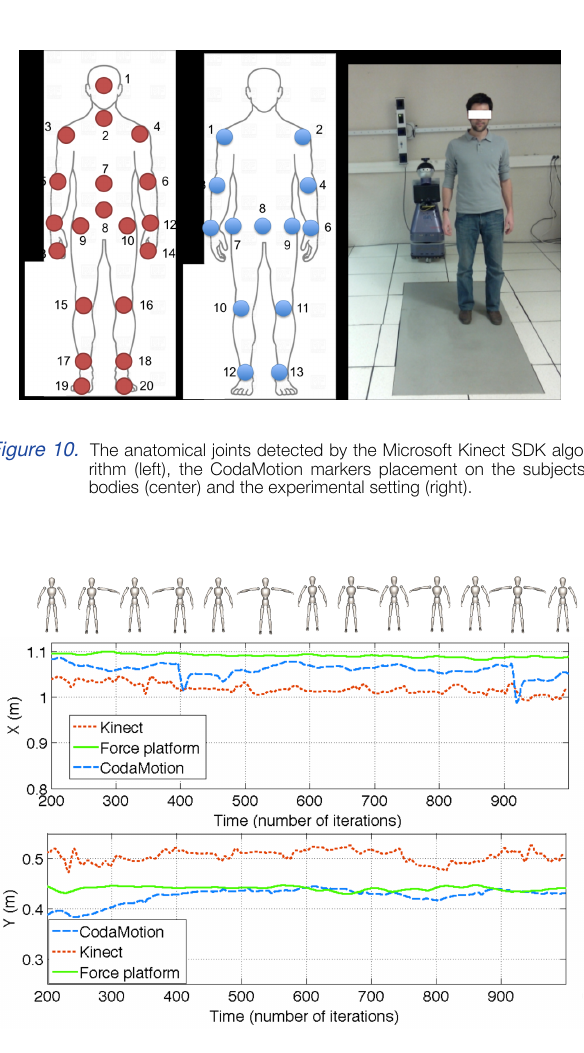
Figure 11. CoP trajectory results of arms movement for a subject. The trajec- tories issued from Kinect and CodaMotion data are calculated by